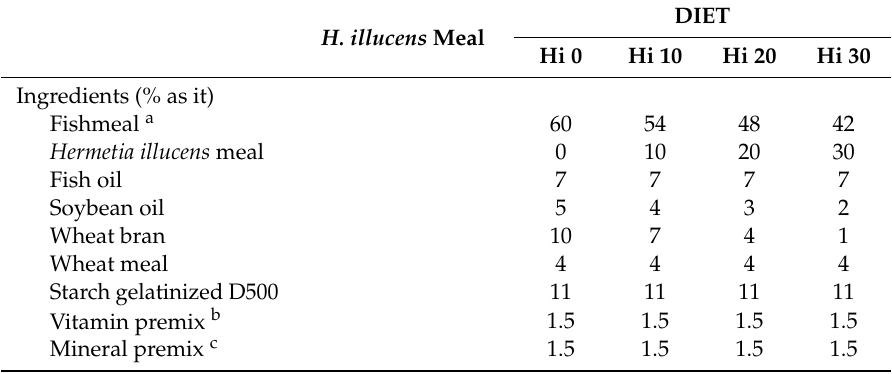
Table 1. Diet formulation and proximate composition (modified from Terova et al.